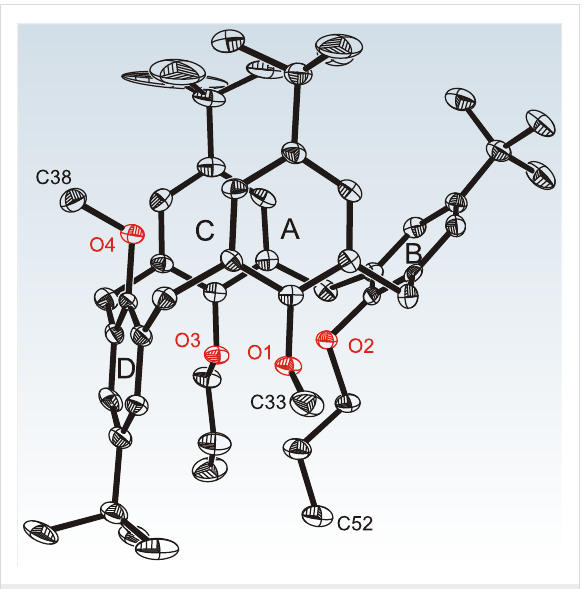
Figure 3: Crystal structure of compound 12 . For clarity only one of the two crystallographically independent molecules is presented; 12(1) and H-atoms are